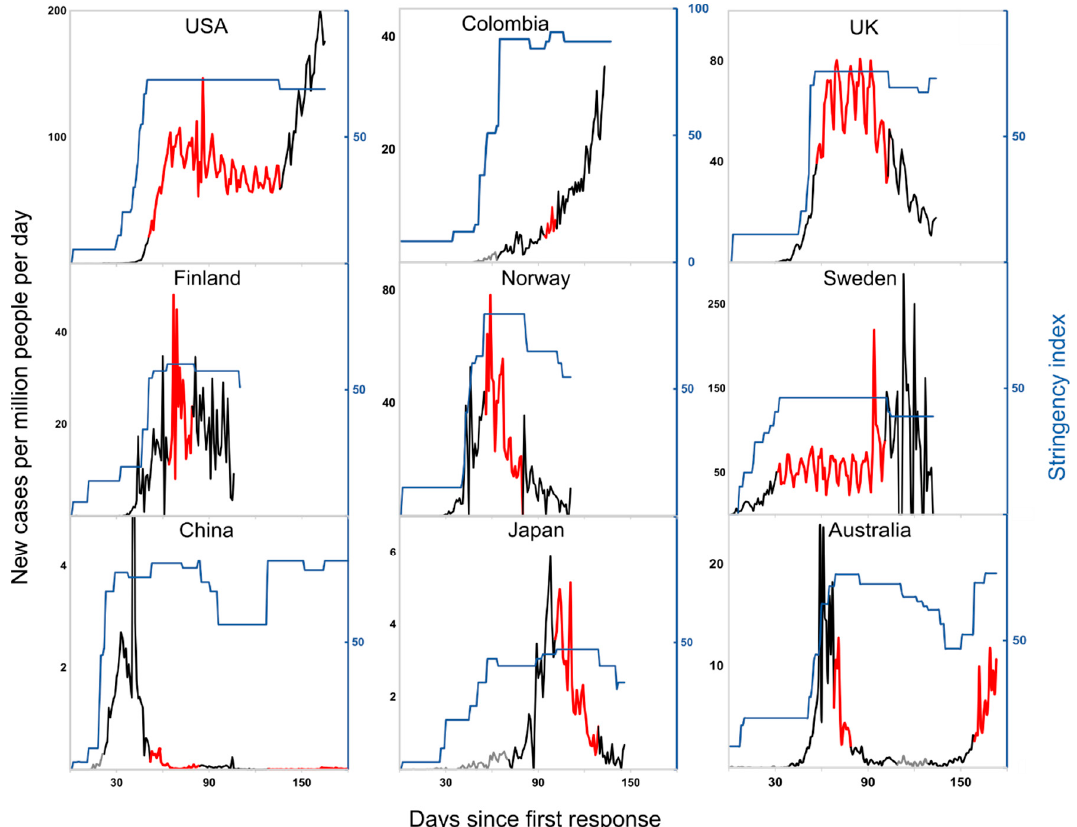
Figure 1. Stringency index and infection rates. The rate of new cases is shown in black for periods of one month before and one month after a period at maximum stringency index (SI) [10,12], which is highlighted in red. SI over the same period is overlaid in blue and scaled from 0 to 100 in all plots to enable comparisons. Table 2. Average number of daily cases per million people before, during and after periods at maximum stringency.